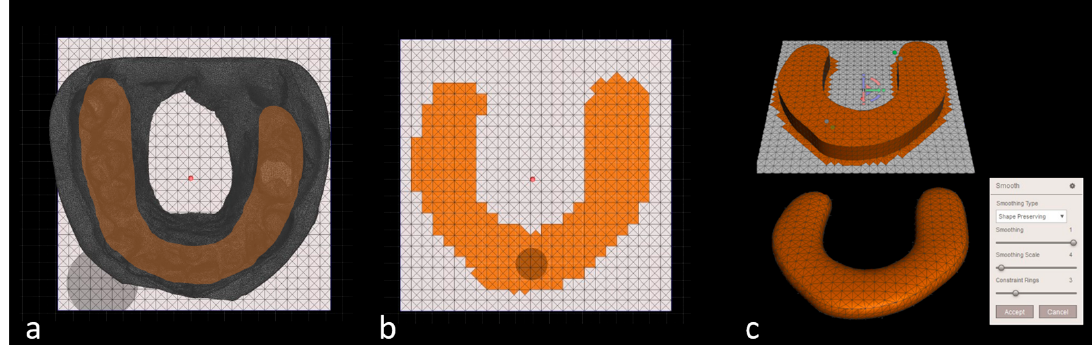
Figure 5. Finalizing the blocked-out maxillary digital cast. ( a ) A 0.2mm offset applied to the blocked- out cast to ensure passive fitting of the overlay. At this stage, the reference blocked-out cast must be deleted by inverting the selection. ( b ) A finalized maxillary blocked-out cast.